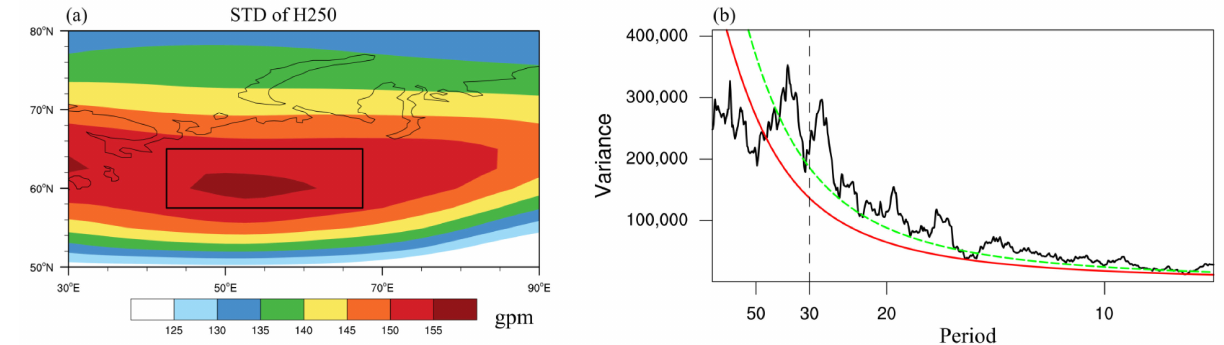
Figure 1. ( a ) Horizontal distribution of the standard deviation of the 250-hPa Z anomaly (with annual cycle and the first three harmonics removed; unit: gpm) over the mid-high-latitude Eurasia in the boreal summer (May–September). The black boxed area (42.5 ◦ –67.5 ◦ E, 57.5 ◦ –65 ◦ N) represents the maximum variability center. ( b ) The power spectra of the area mean 250 hPa Z anomaly, the black solid line denotes the power spectrum, and the red and green lines represent the standard spectrum of red noise and its 0.05 significance level,